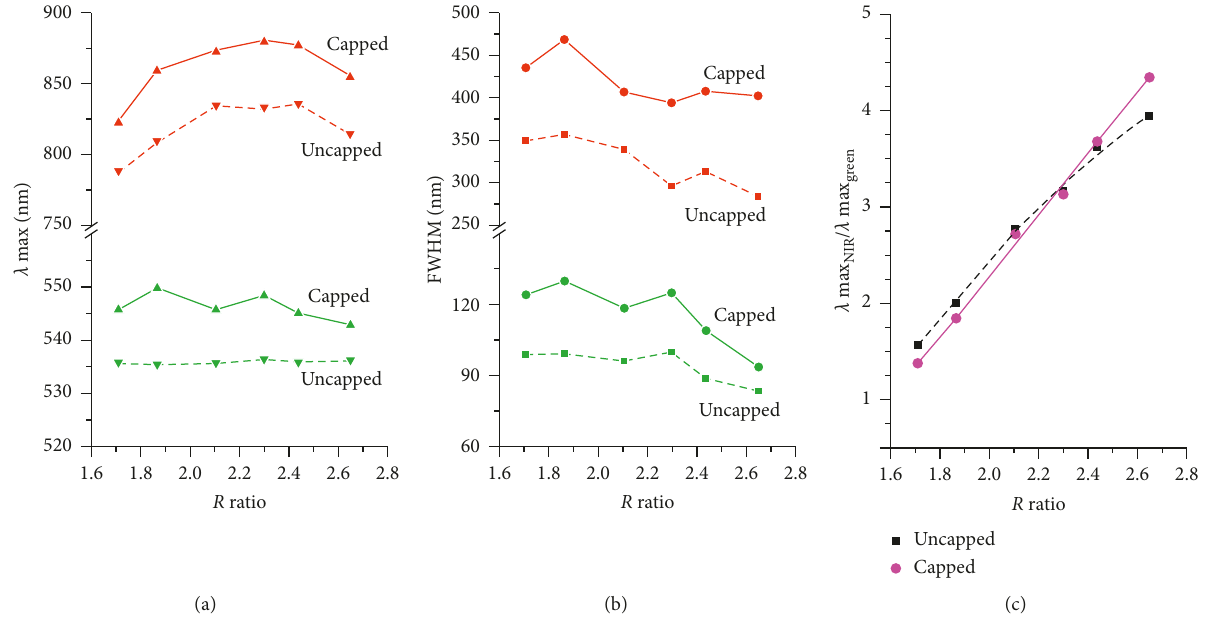
Figure 9: Results of the decomposition of the experimental spectra versus the molar ratio R before and after the chitosan capping. (a) Wavelength of peak absorbances; (b) FWHM of the NIR- and green-tuned bands; (c) ratio between the maxima in the NIR band ( M NIR ) and in the green band ( M Green ). The straight lines are only a guide for the